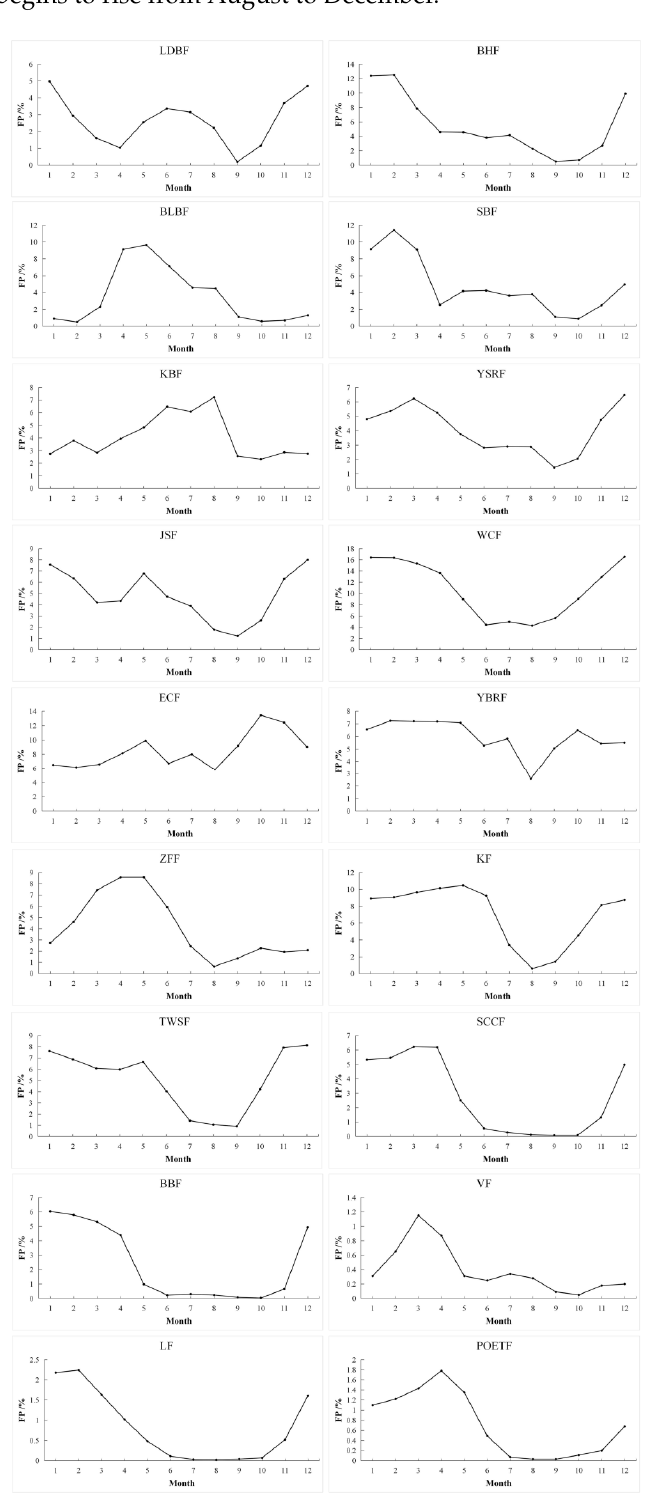
Figure 3. The line chart of monthly change in frontal frequency in 18 frontal